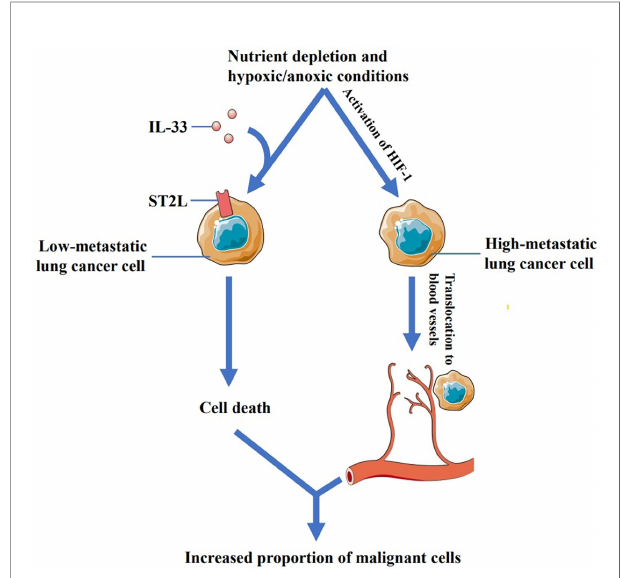
FIGURE 1 | Low-metastatic cells derived from Lewis lung carcinoma express ST2L while high-metastatic cells do not. IL-33 can increase the cell death in low metastatic Lewis lung cancer cells under nutrient depletion and hypoxic/ anoxic conditions, while ST2L-negative high-metastatic lung cancer cells are not affected by IL-33. IL-33 thus provides a selective pressure for ST2L-negative cells that might expand into regions adjacent to the tumor blood vessels following hypoxia-inducible factor 1 (HIF-1)-dependent translocation, thereby increasing the proportion of the malignant